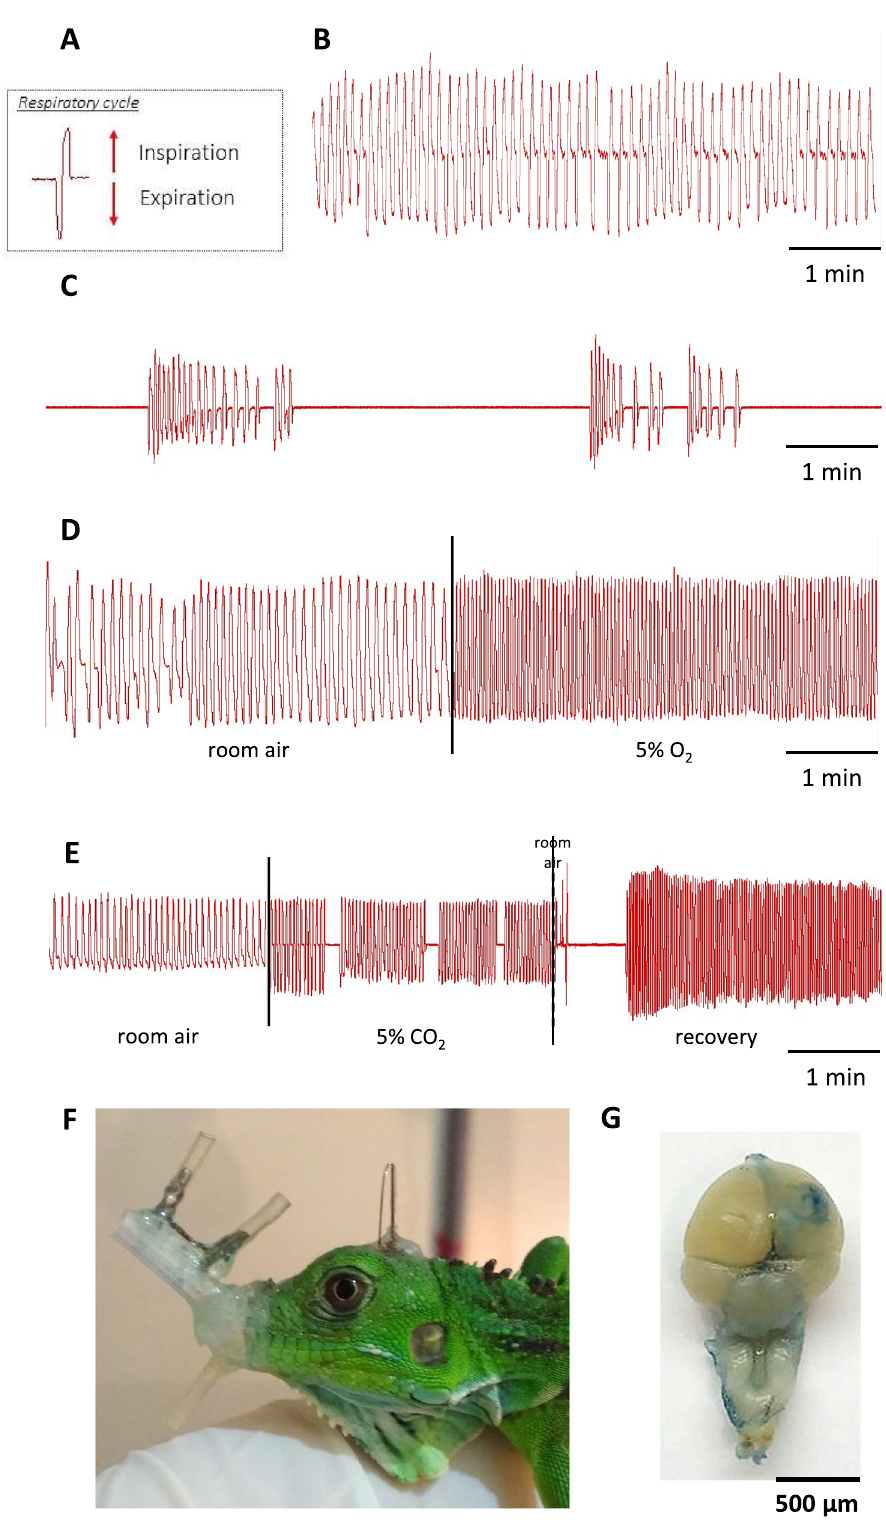
Figure 3. Representative pneumotachographic recordings of the different breathing patterns observed in Iguana iguana . Respiratory cycle ( A ). Representative traces from normocarbic normoxia (vehicle group) during light phase ( B ), normocarbic normoxia during dark phase ( C ), hypoxia 5% O 2 during light phase ( D ) and hypercarbia 5% CO 2 and recovery during light phase ( E ). The breathing pattern during the exposition to hypoxia or hypercarbia during the light and dark phases is similar, thus, only figures of the light phase are represented. Iguana with the pneumotachograph attached ( F ). Brain injected with Evans blue ( G